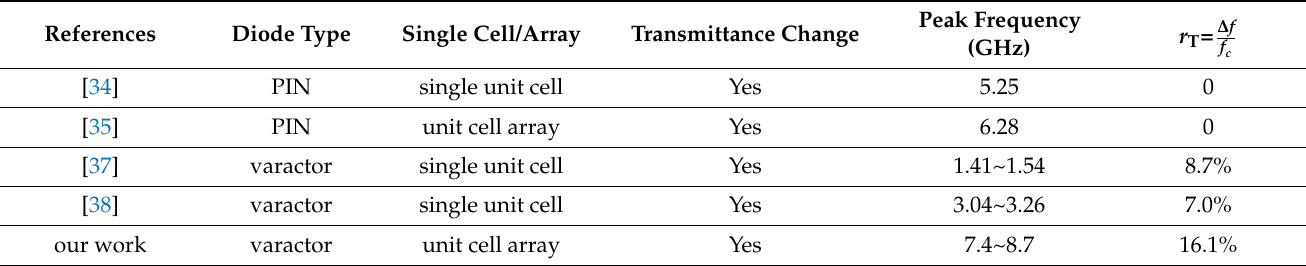
Table 2. EIT metamaterial performance literature